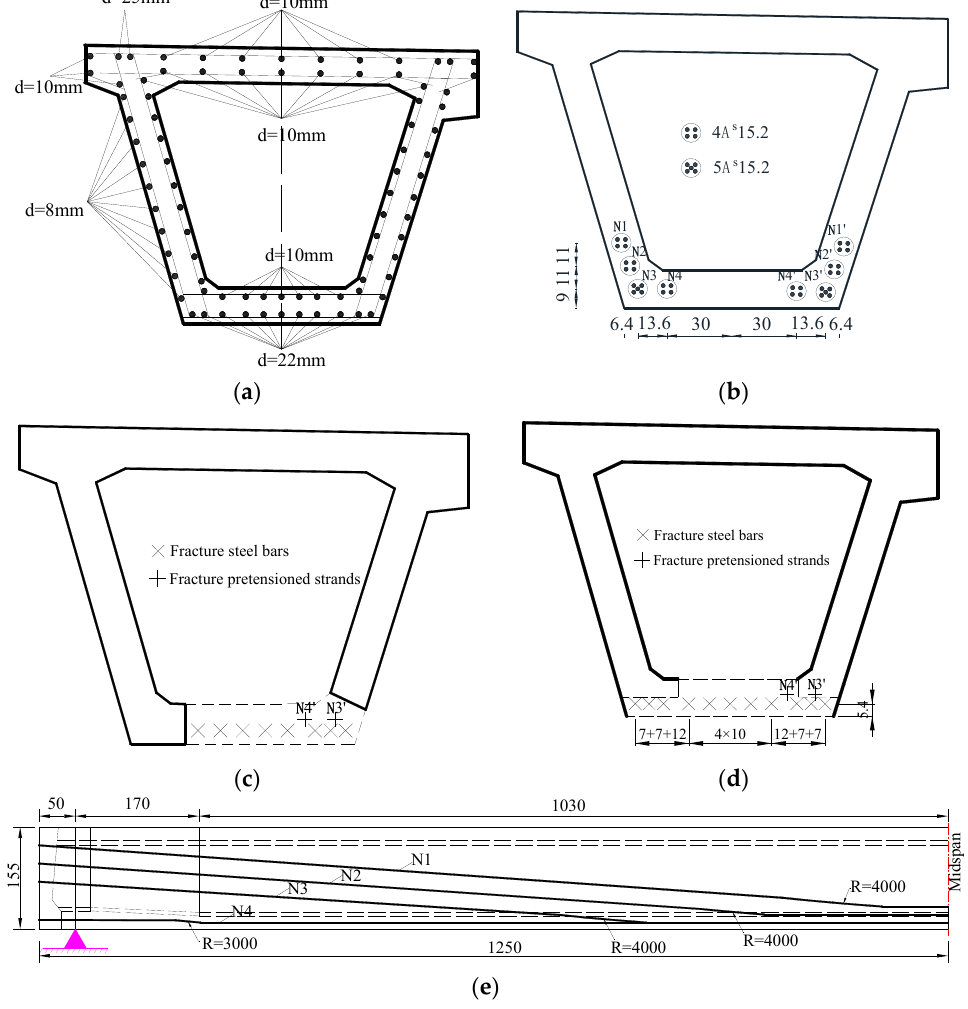
Figure 4. Arrangement of steel bars and strands in the girder (Unit: cm). ( a ) Steel bars in the undamaged girder (B-B); ( b ) Pretensioned strands in the undamaged girder (B-B); ( c ) Steel bars in the damaged region of the #4-2 girder (C-C); ( d ) Steel bars in the damaged region of the #3-2 girder (C-C); ( e ) Strands arrangement.